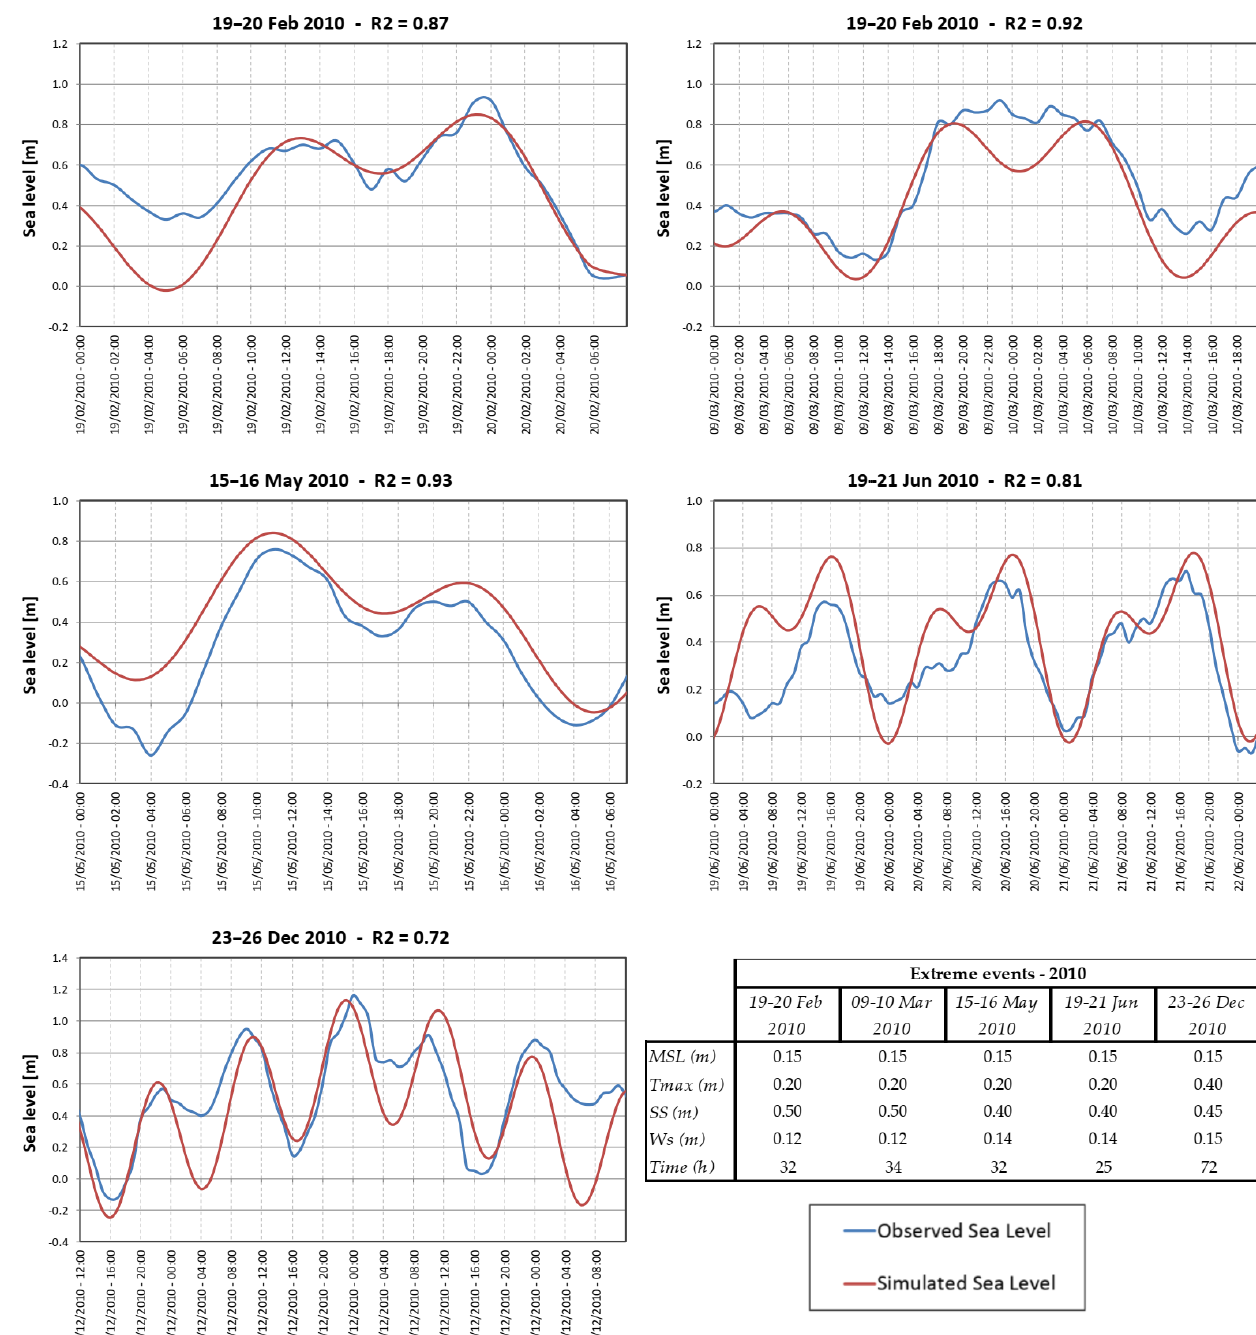
Figure A2. Comparison of the observed sea level (in blue) versus the simulated sea level using the harmonic components (in red).